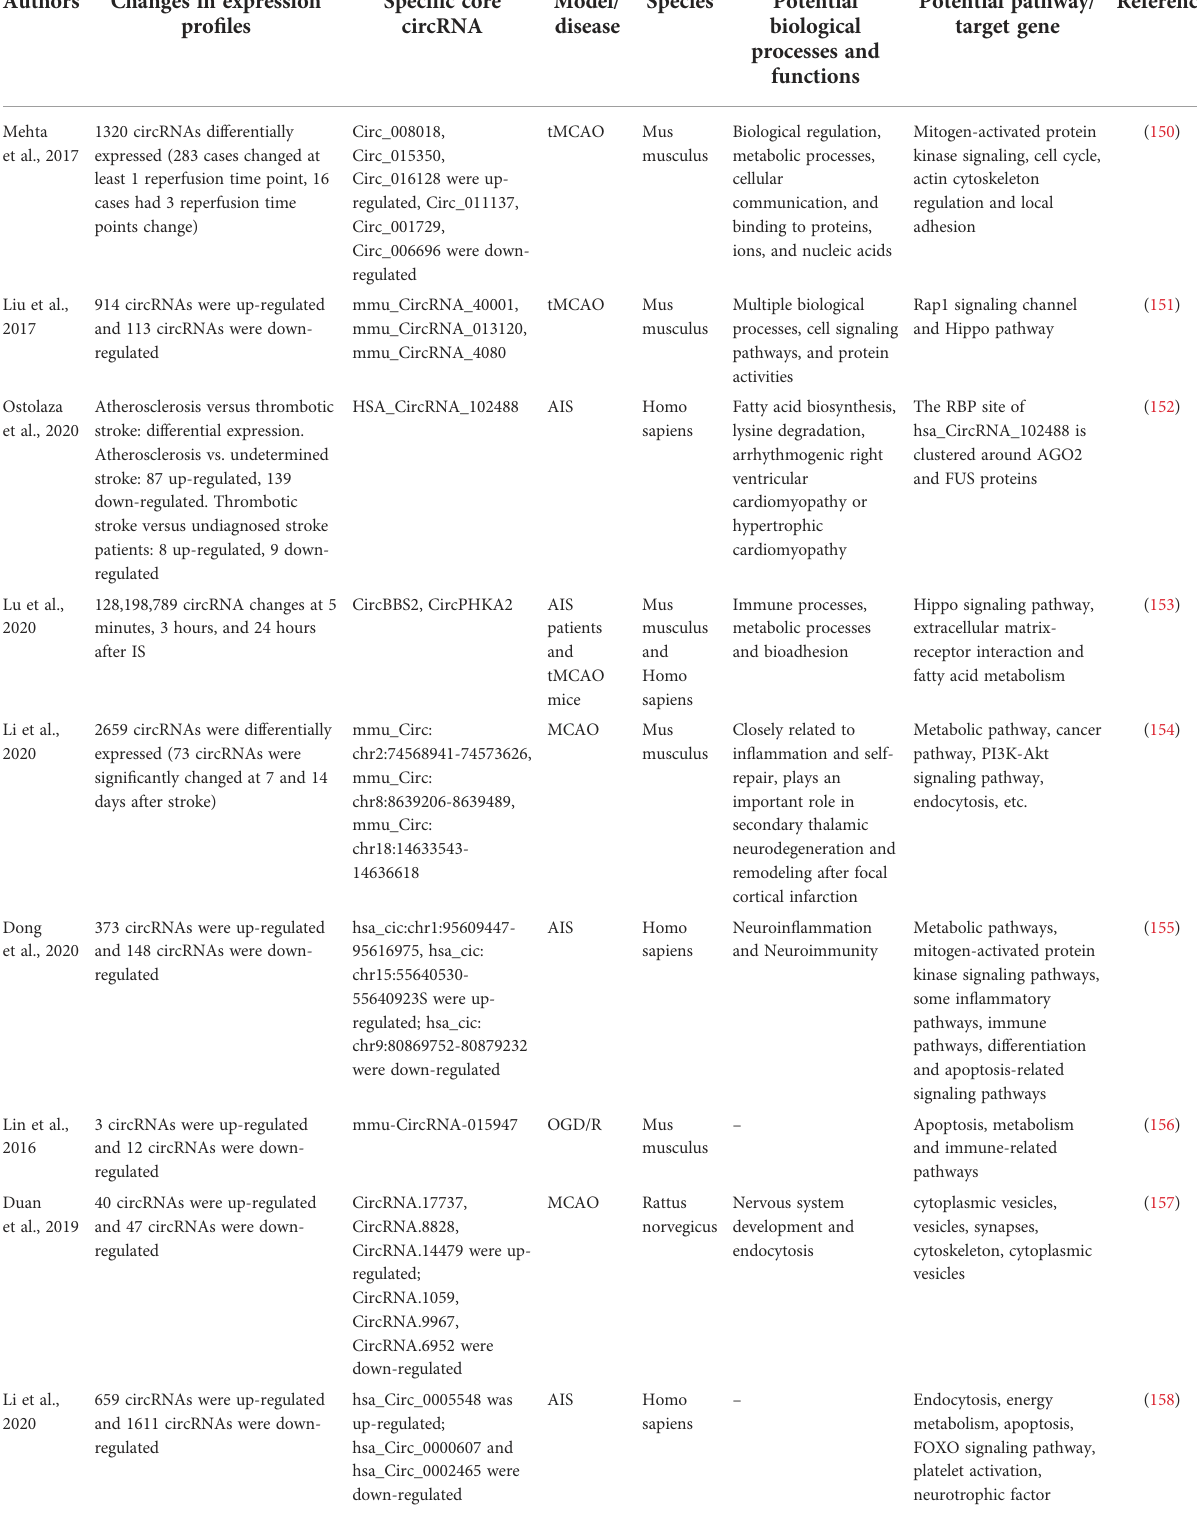
TABLE 6 Summary of the mechanisms of circRNAs in cerebral ischemia (Sequencing